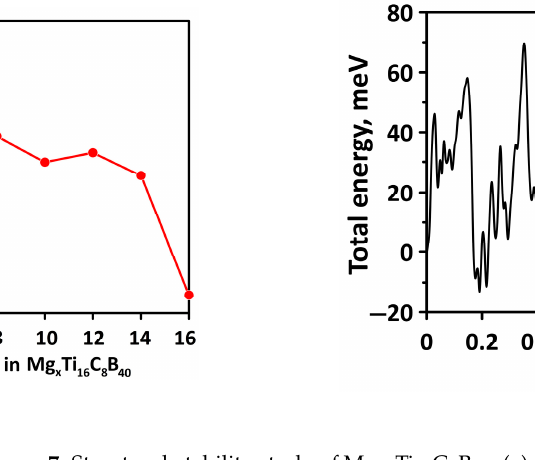
Figure 7. Structural-stability study of Mg 16 Ti 16 C 8 B 40 : ( a ) change in the surface area of Mg 16 Ti 16 C 8 B 40 during the process of magnesium embedding; ( b ) change in the total energy of Mg 16 Ti 16 C 8 B 40 as a function of time during molecular-dynamics simulation.